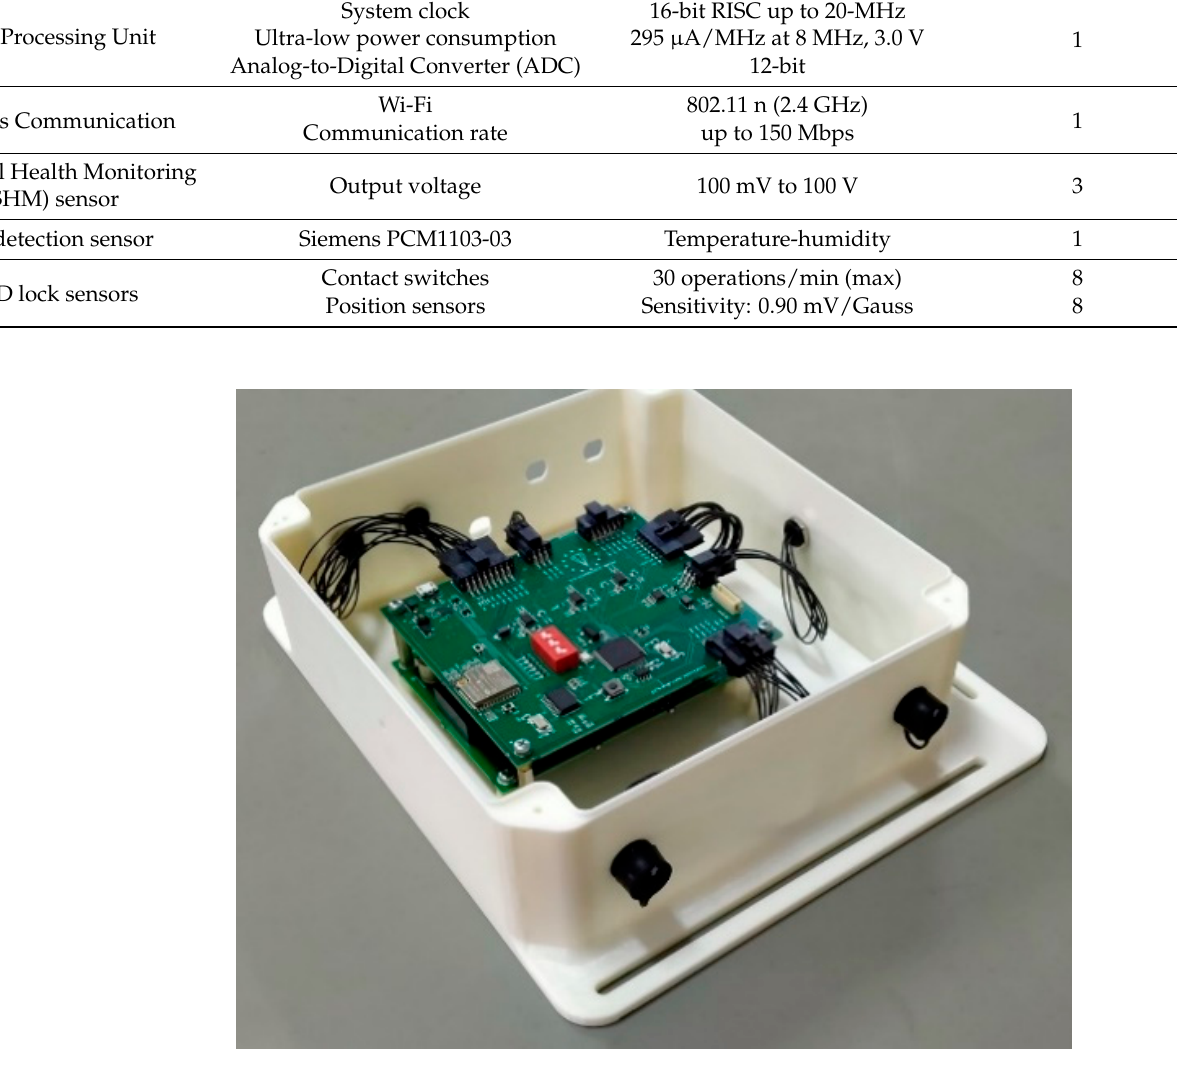
Figure 5. The Remote Monitoring and Control (RMC) system inside its Housing.